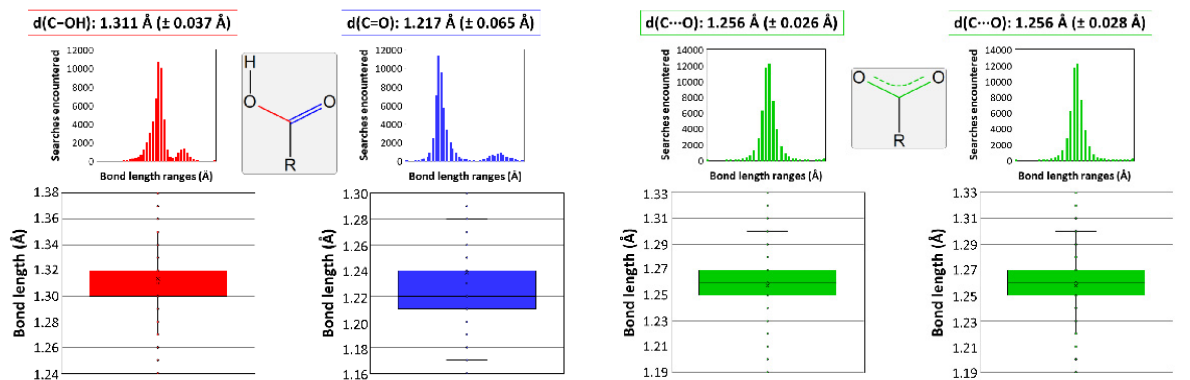
Figure 3. Data analysis on the C-O bond length variation depending on the functional group. Colors correspond to bonds that can be found in a carboxylic group (data in red belong to the C-OH bond and in blue to the C=O bond), and in a carboxylate group coordinated to a metal (describing with green color the data corresponding to the C···O bond).